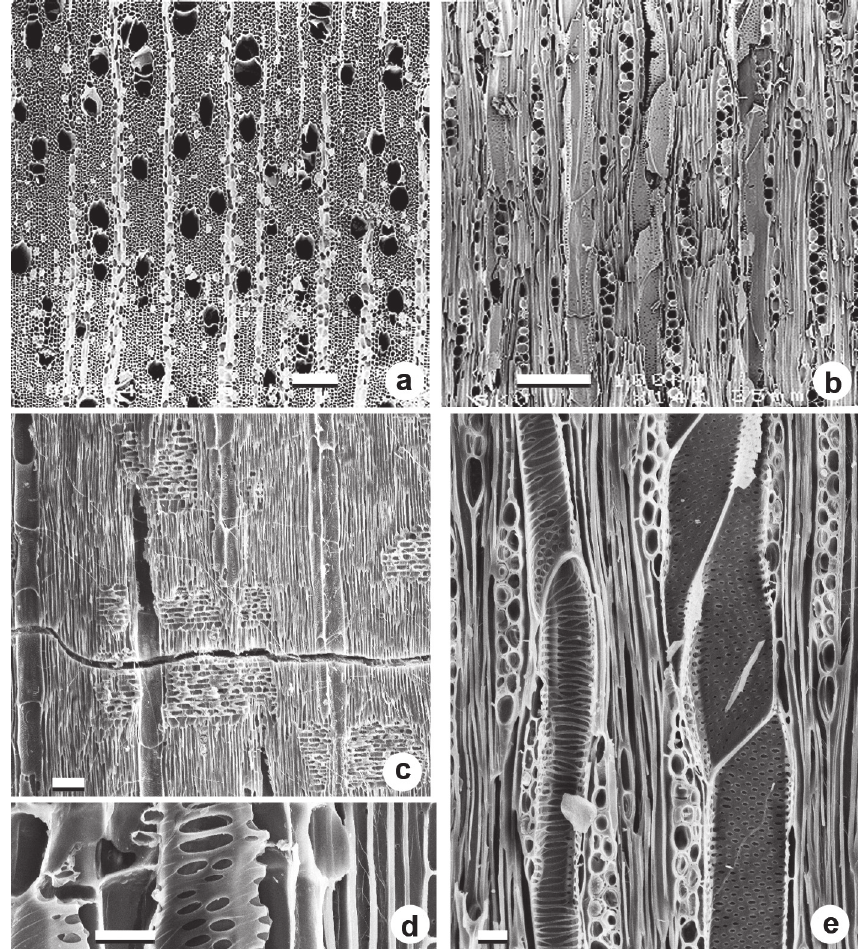
Figure 3. Lithrea molleoides (USPw 520). Platinum-coated, UM-II ( a-b ), gold-coated, CETEM ( c-e ). - a : Transverse section. - b : Tangential section. - c : Radial section. - d : Vessel-ray pits. - e : Spiral thickenings in some vessels. Bars = 100 µm ( a-c ) and 20 µm ( d-e